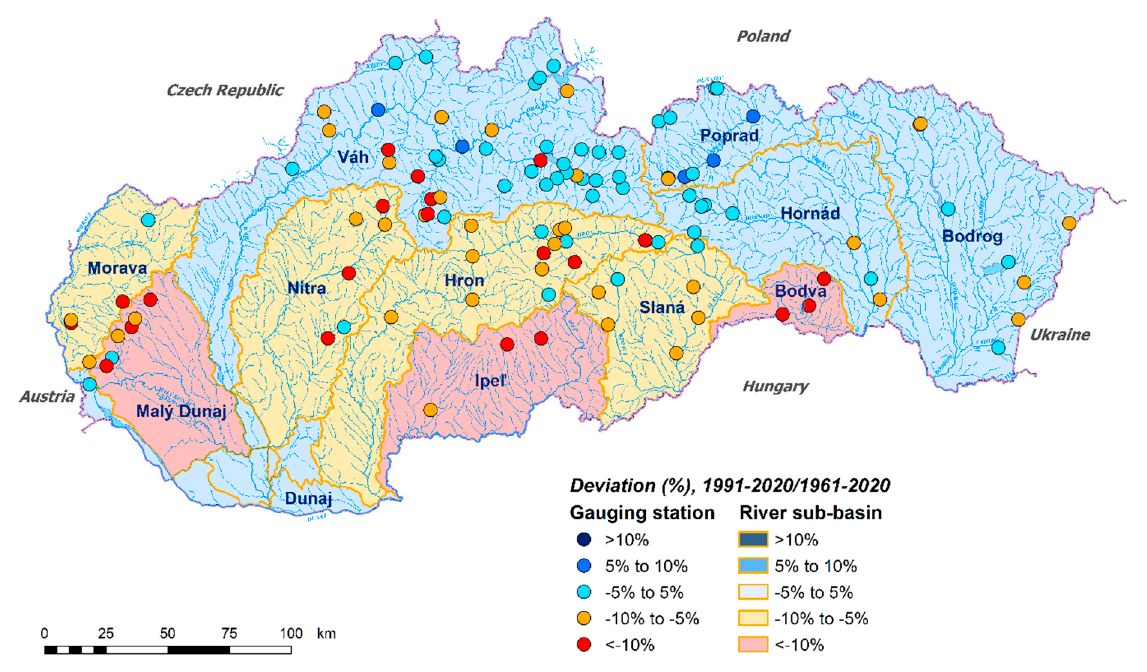
Figure 7. The flow rates average deviation (%) for the area of Slovakia and the river sub-basins and evaluated water-gauging stations for the period 1991–2020 (reference period 1961–2020).